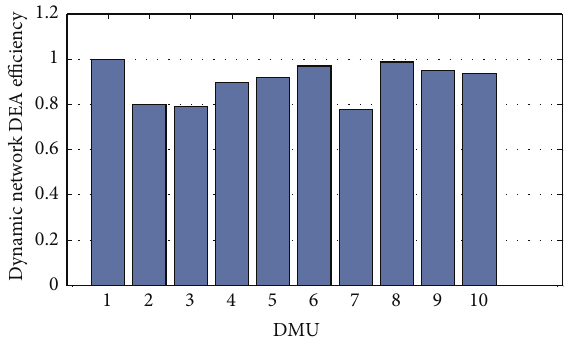
Figure 8: Dynamic network DEA efficiency of 10 DMUs.